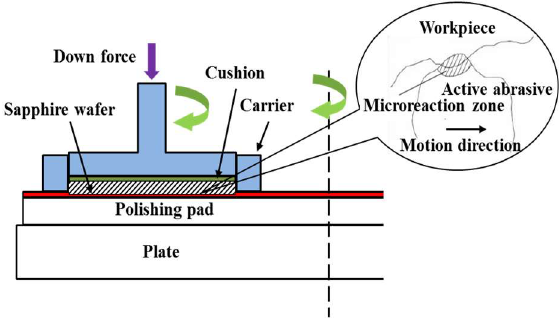
Figure 1. Illustration of mechanical chemical polishing (MCP).